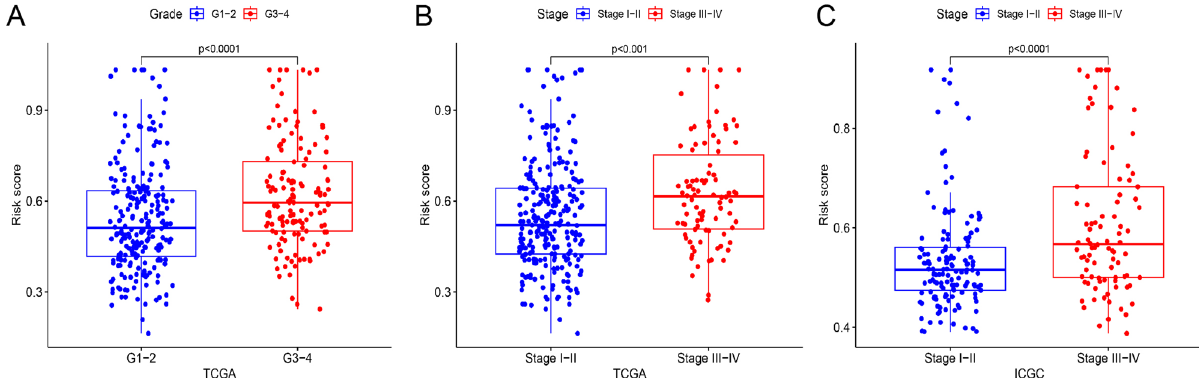
Figure 5. Risk score-related clinicopathological features. ( A , B ) Grade and stage in TCGA cohort. ( C ) Stage in ICGC